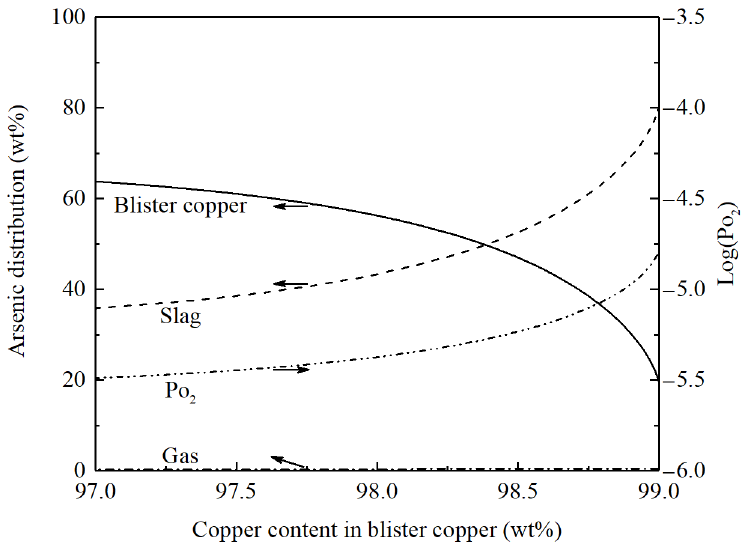
Figure 1. Effect of copper content in blister copper on arsenic distribution at 1290 °C with a slag Fe/SiO 2 ratio of 1.7.